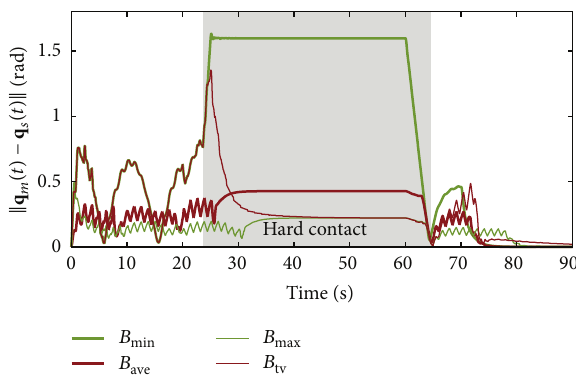
Figure 8: Master-slave coordination error for constant wave impedances 𝐵 min = 10 , 𝐵 wave impedance 𝐵